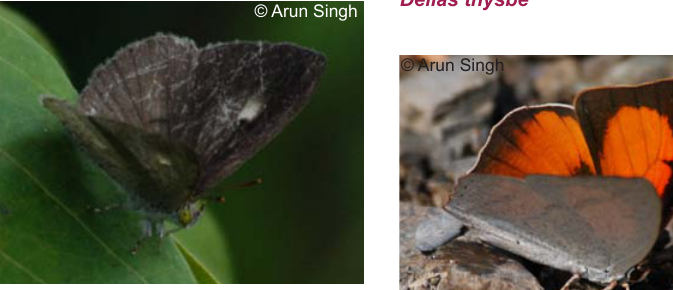
Image 26. Apefly Spalgis epius